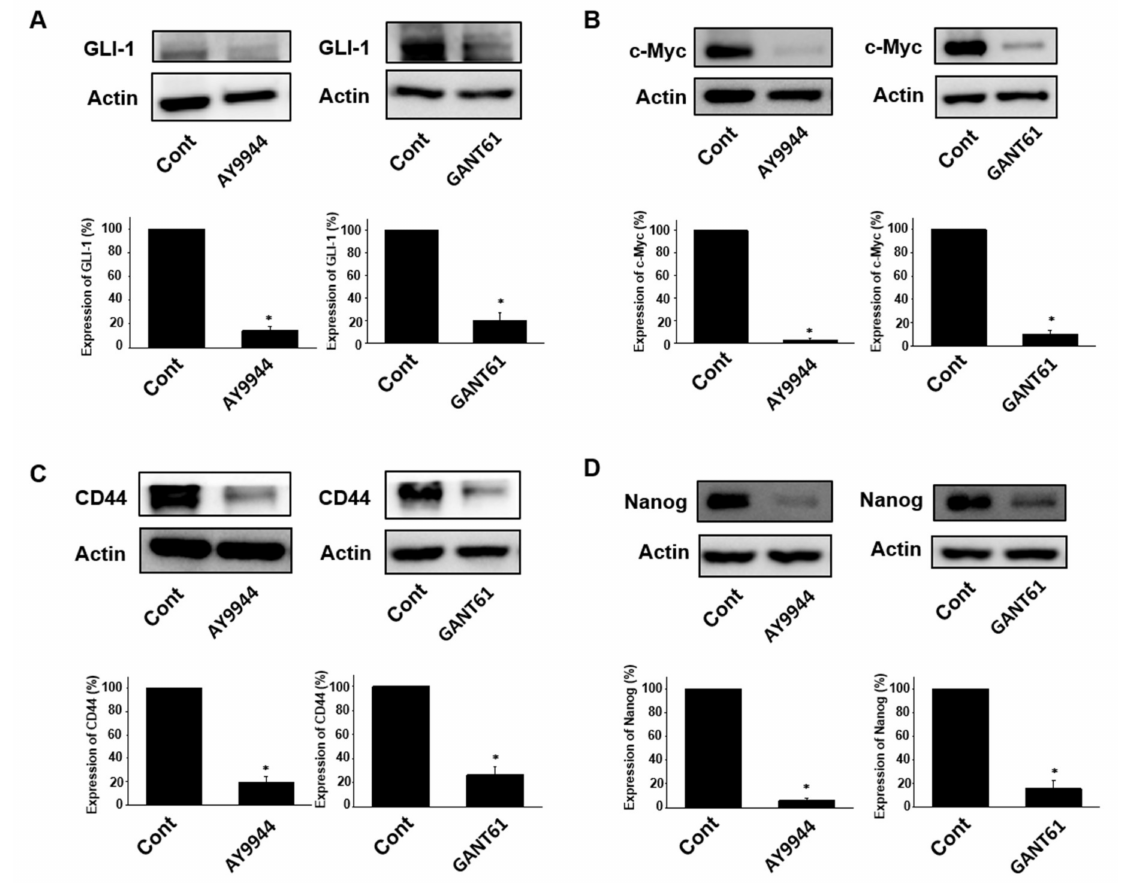
Figure 1. Effects of Hedgehog signal inhibitors on expression of stem cell marker proteins in tumor ALI organoids. After the organoids were treated with GANT61 (10 µ M) or AY9944 (10 µ M) for six days, protein expression was determined by Western blotting: GLI-1 ( n = 4–5) ( A ); c-Myc ( n = 4–5) ( B ); CD44 ( n = 4–5) ( C ); and Nanog ( n = 4–5) ( D ). Equal protein loading was confirmed using total actin antibody. * p < 0.05 vs.